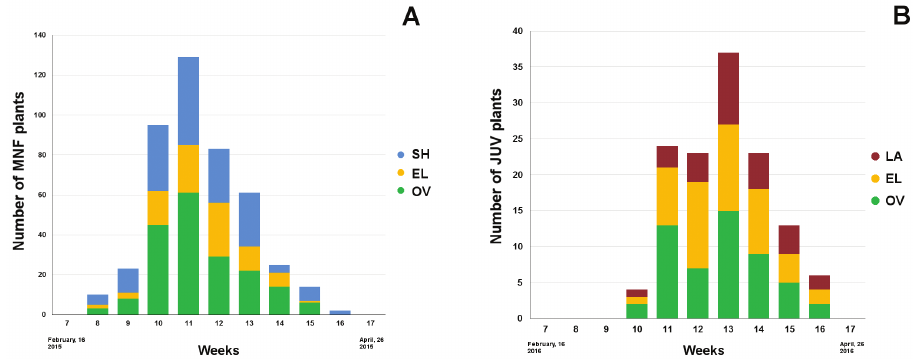
Figure 3. Leaf shape in new plants of E. dens-canis . Histograms of A mature non-flowering individuals (MNF) with oval (OV), shield-like (SH) and elongate (EL) leaf shapes, and B juvenile (JUV) plants with oval (OV), elongate (EL) and lanceolate (LA) leaf